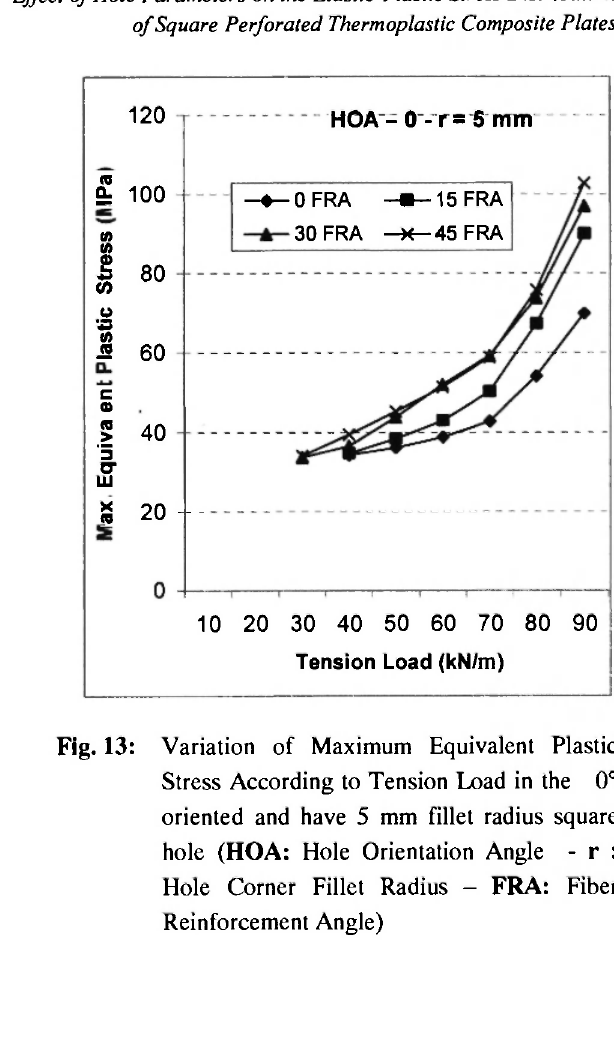
expansion around the square hole corner (0° hole orientation angle, unfiilet and 0° fibre reinforced